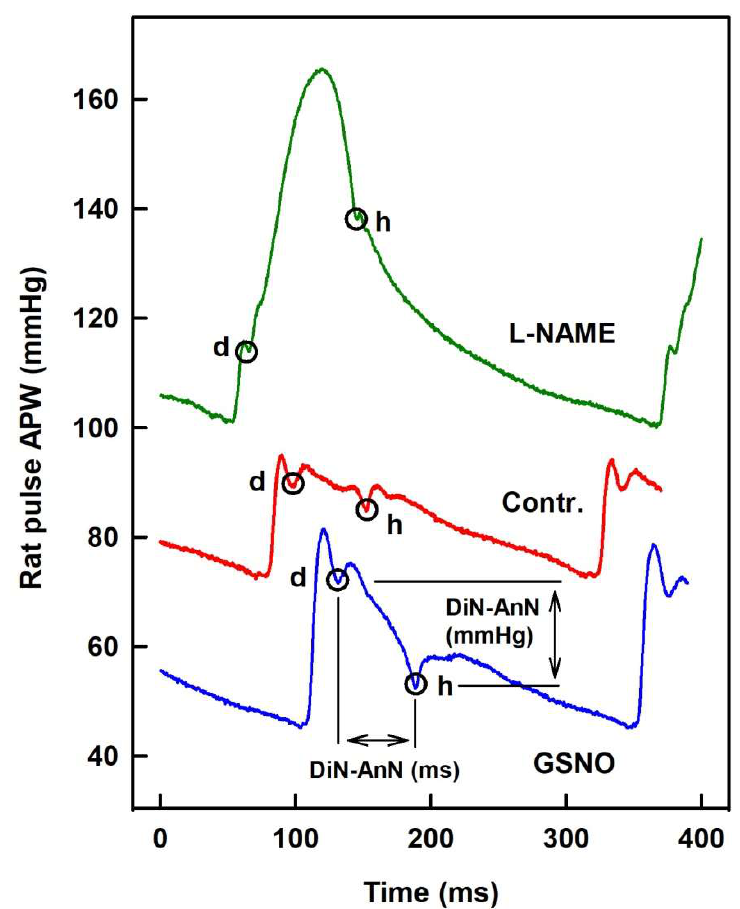
Figure 1. The left common carotid artery pulse waveform (APW) in the anesthetized rat. Anacrotic (AnN) notch ( d ) and dicrotic (DiN) notch ( h ) marked at control APW (red) and after i.v. administration of 32 nmol kg −1 NO-donor S-nitrosoglutathione (GSNO) (blue) or 25 mg kg −1 L-NAME (green). For the definition of time interval (DiN-AnN in ms) and the difference of blood pressure (BP) (DiN-AnN in mmHg) of dicrotic and anacrotic nothes, see Supplementary Materials Figure S1.